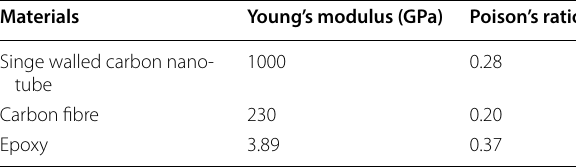
Table 1 Properties of fibres and matrix materials [5,